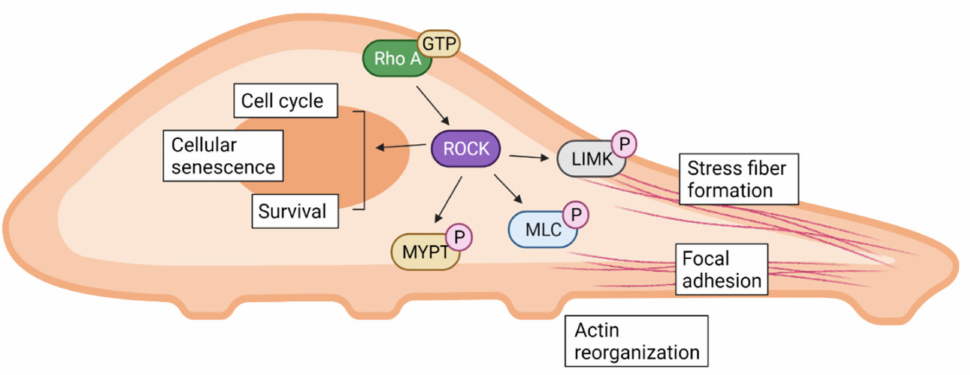
Figure 1. The Rho/ROCK signaling pathway in cell biology. The Rho/ROCK signaling regulates fundamental cellular activities including actin reorganization, focal adhesion, and stress fiber formation, altering various cellular